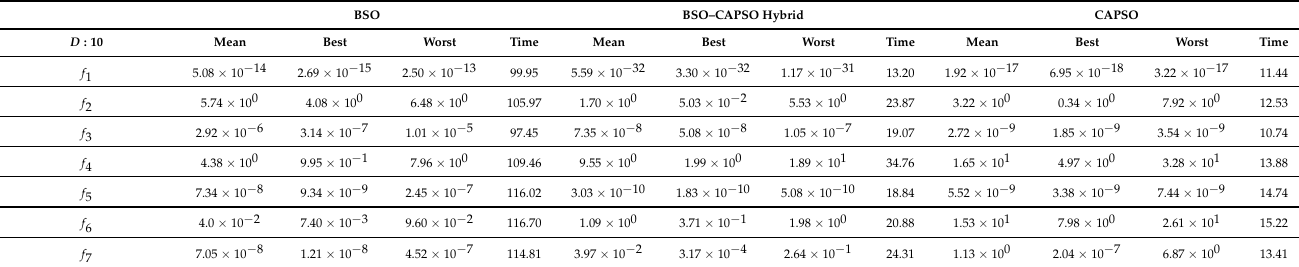
Table 3. Simulation results for D = 10.